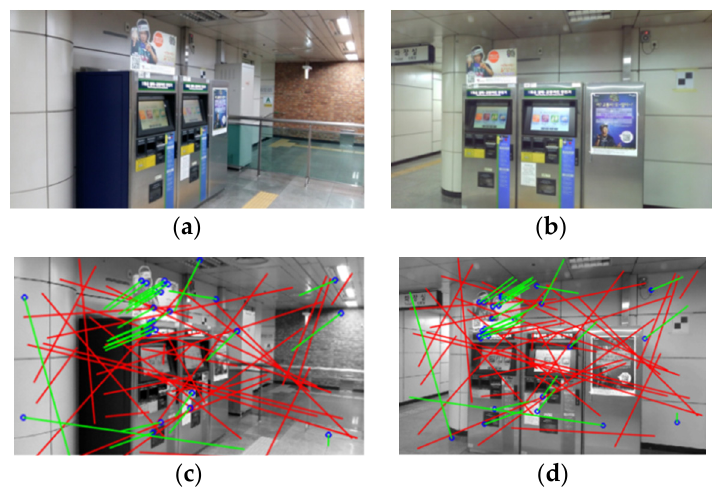
Figure 14. An example of quite good solution for Bangbae station, image No. 8: ( a ) query image; ( b ) reference image from DB; ( c ) query image; and ( d ) reference image with used feature points; the matched points that have been rejected are in red.